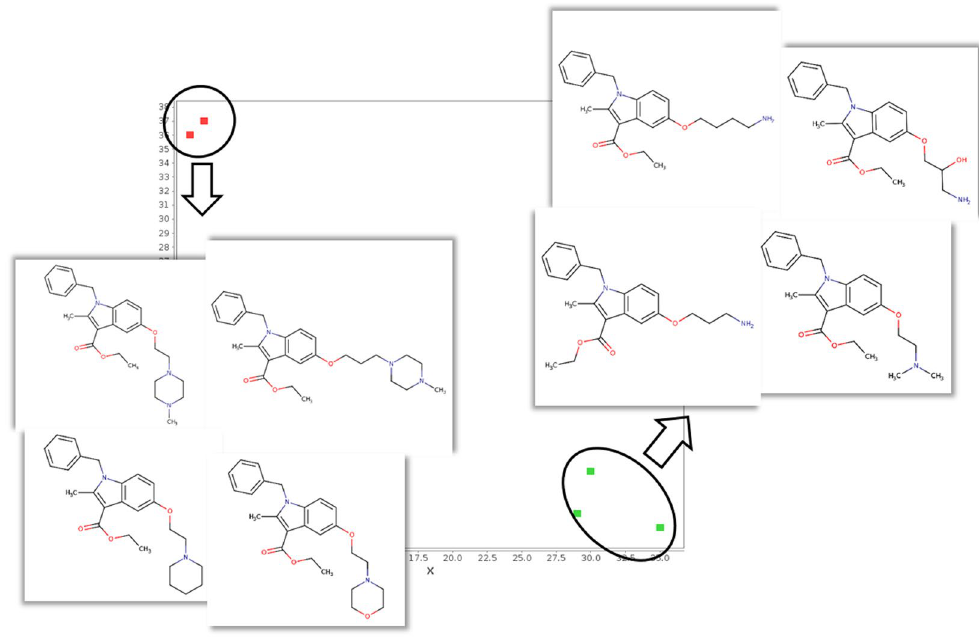
Figure 7. Spatial disposition of structurally similar molecules over the ADME-Space. Nodes are coloured by human metabolic stability (green: stable; red: unstable).